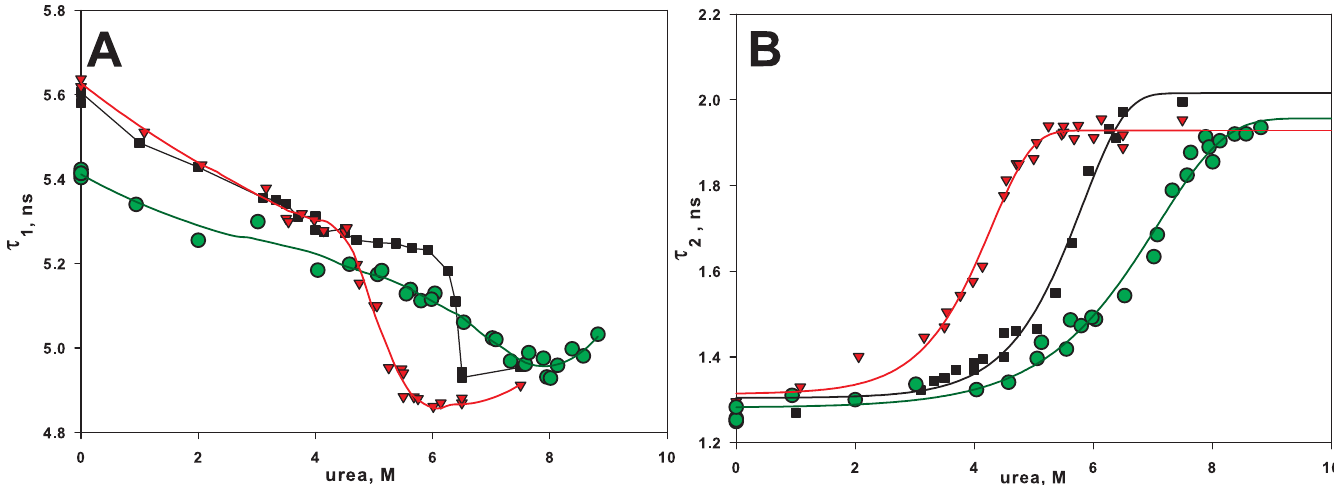
Fig 3. Effect of urea on fluorescence lifetimes of BCA II. Dependence of fluorescence lifetimes τ 1 (A) and τ 2 (B) on urea concentration of wild-type BCA II ( ■ WT) and its two mutant forms ( ▼ L139A and ● A53C-A76C). The relative deviations for τ 1 and τ 2 were � 3% and � 7% correspondingly. The solid lines are to guide the eyes.